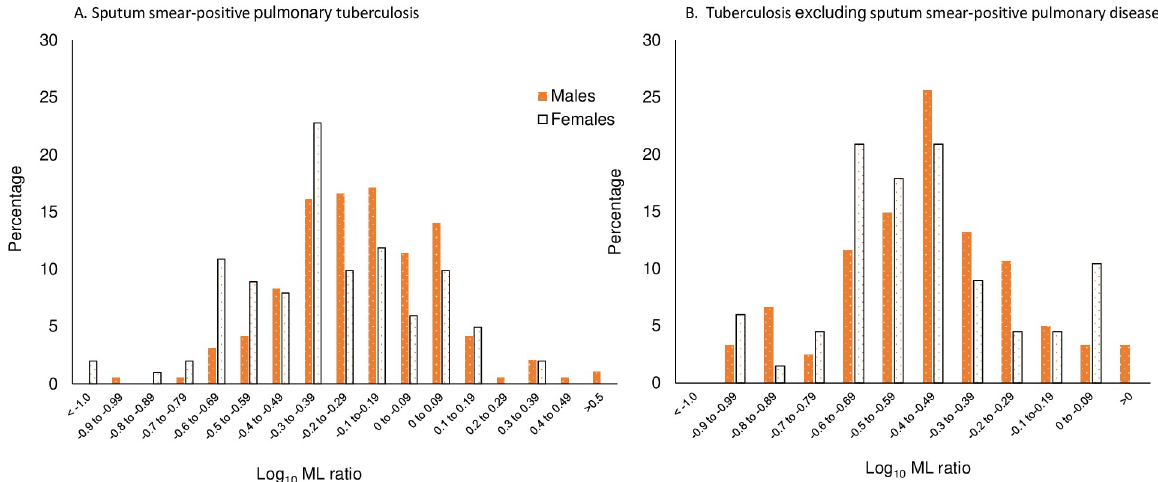
Fig 3. Monocyte-to-lymphocyte ratios and sex. A. Patients with sputum smear-positive pulmonary tuberculosis. B. Patients with tuberculosis excluding sputum smear-positive pulmonary disease. Males show higher values than females.